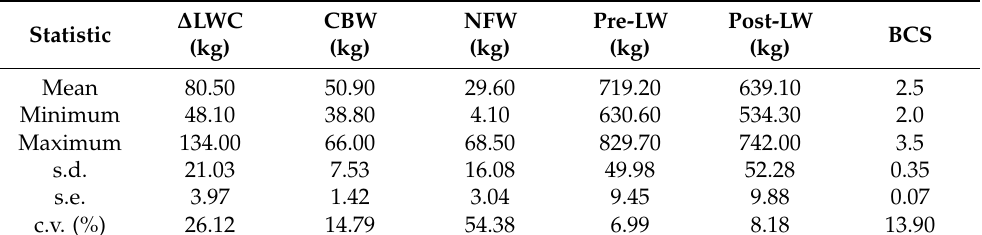
Table 1. Descriptive statistics (mean, minimum, maximum, s.d. -standard deviation-, s.e. -standard error-, c.v. -coefficient of variation-) of cow liveweight change at calving ( ∆ LWC), cow non-foetal weight loss at calving (NFW), cow pre-calving liveweight (pre-LW), cow post-calving liveweight (post-LW), and calf birth weight (CBW) ( n = 28).